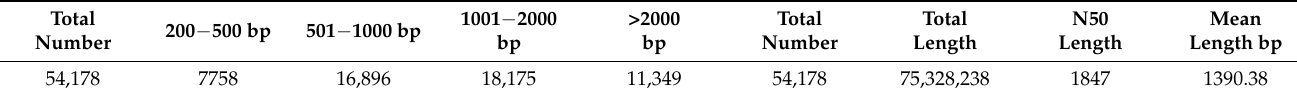
Table 2. Results of transcriptome